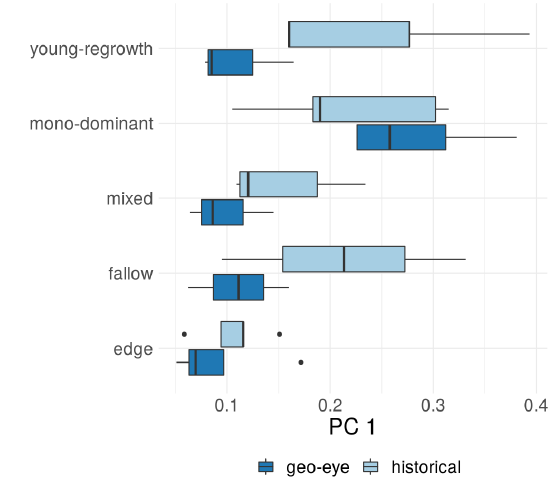
Figure 8. Visual comparison between a historical ( A ) and contemporary ( B ) permanent sampling plot. The site is currently listed as a mono-dominant Brachystegia laurenttii stand: Note the structural differences with a “courser” canopy structure in the historical image compared to the more closed contemporary stand.